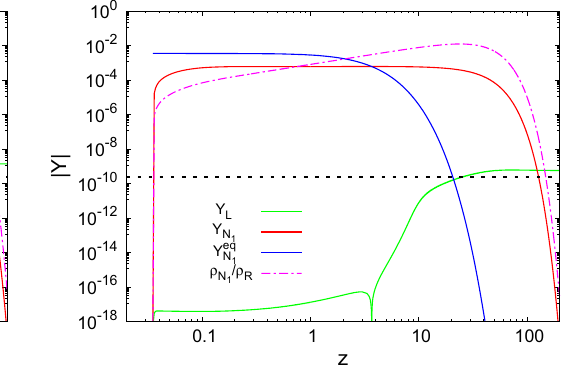
Fig. 1 Evolution of Y N equations. The left panel is one for the case (D) in Table 1 and the right panel is one for the case (F).Initial values for them are fixed as